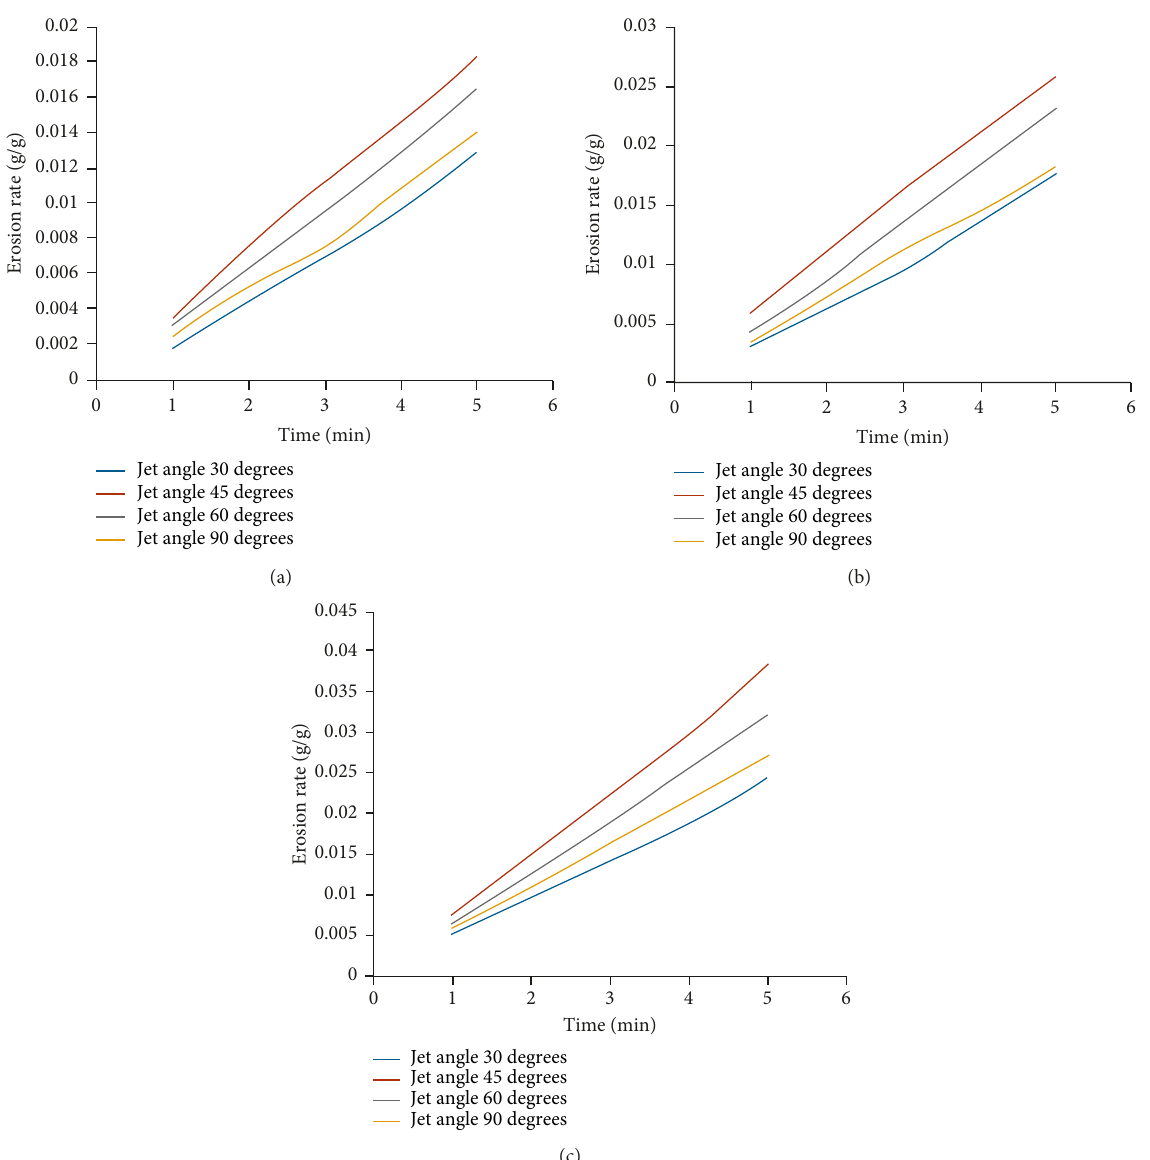
Figure 6: 5 layers glass fibre (a) 1 bar pressure and 10% micro carbon powder filler. (b) 1.5 bar pressure and 10% micro carbon powder filler. (c) 2 bar pressure and 10% micro carbon powder